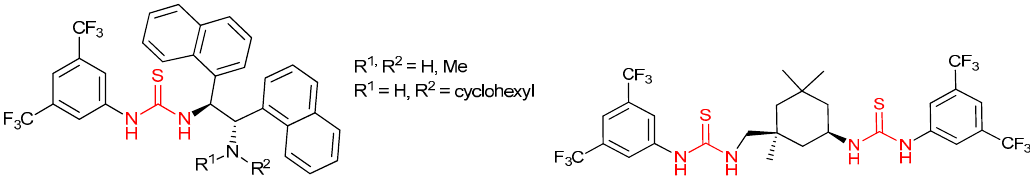
Figure 13. Chiral thioureas preparaed by the groups of Tius (left) [184,185] and Berkessel (right) [186].